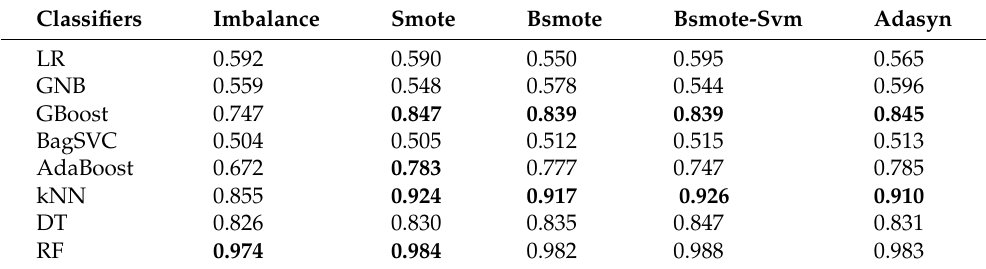
Table 8. Comparison of classifiers (on AUC %) for imbalanced datasets and different oversampling methods for the power system dataset.